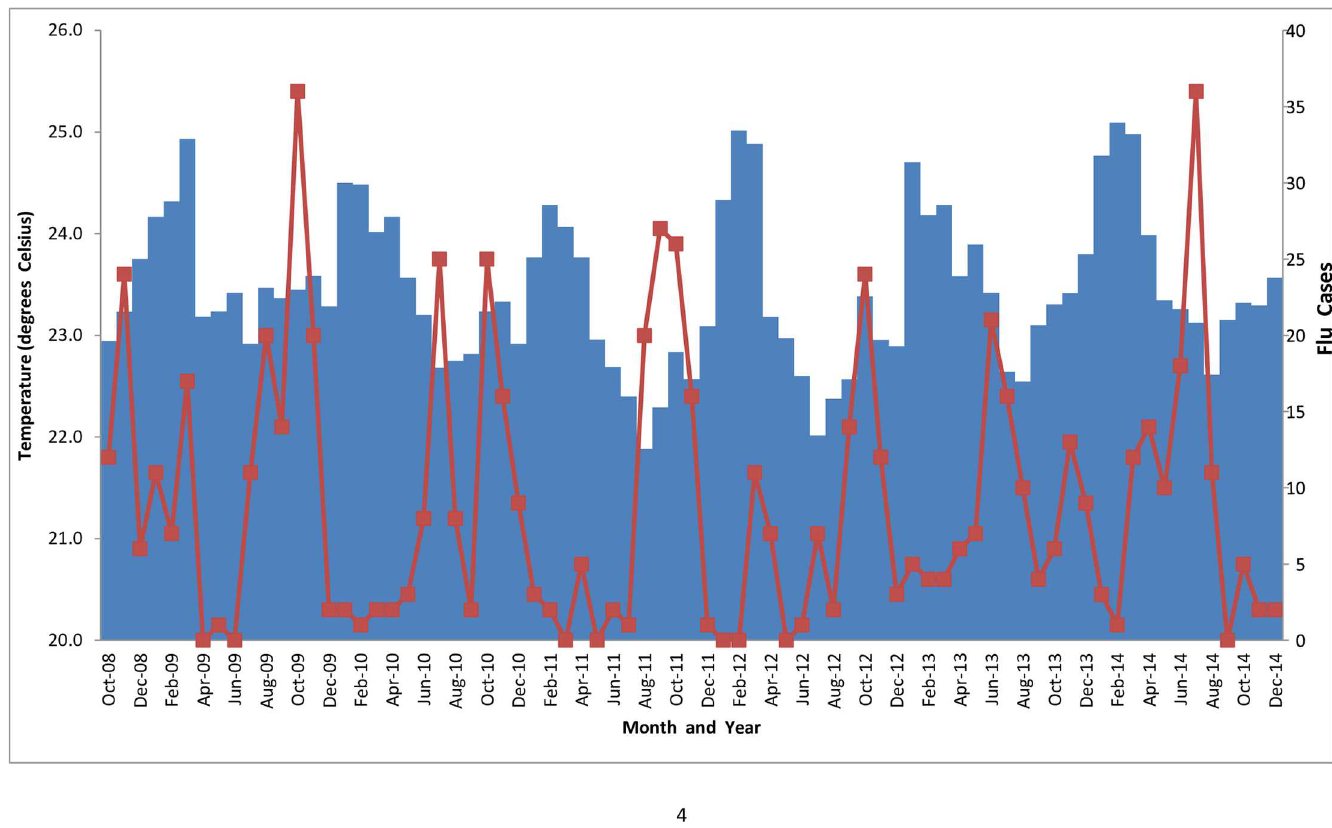
Fig 5. Average temperatures and monthly number of flu